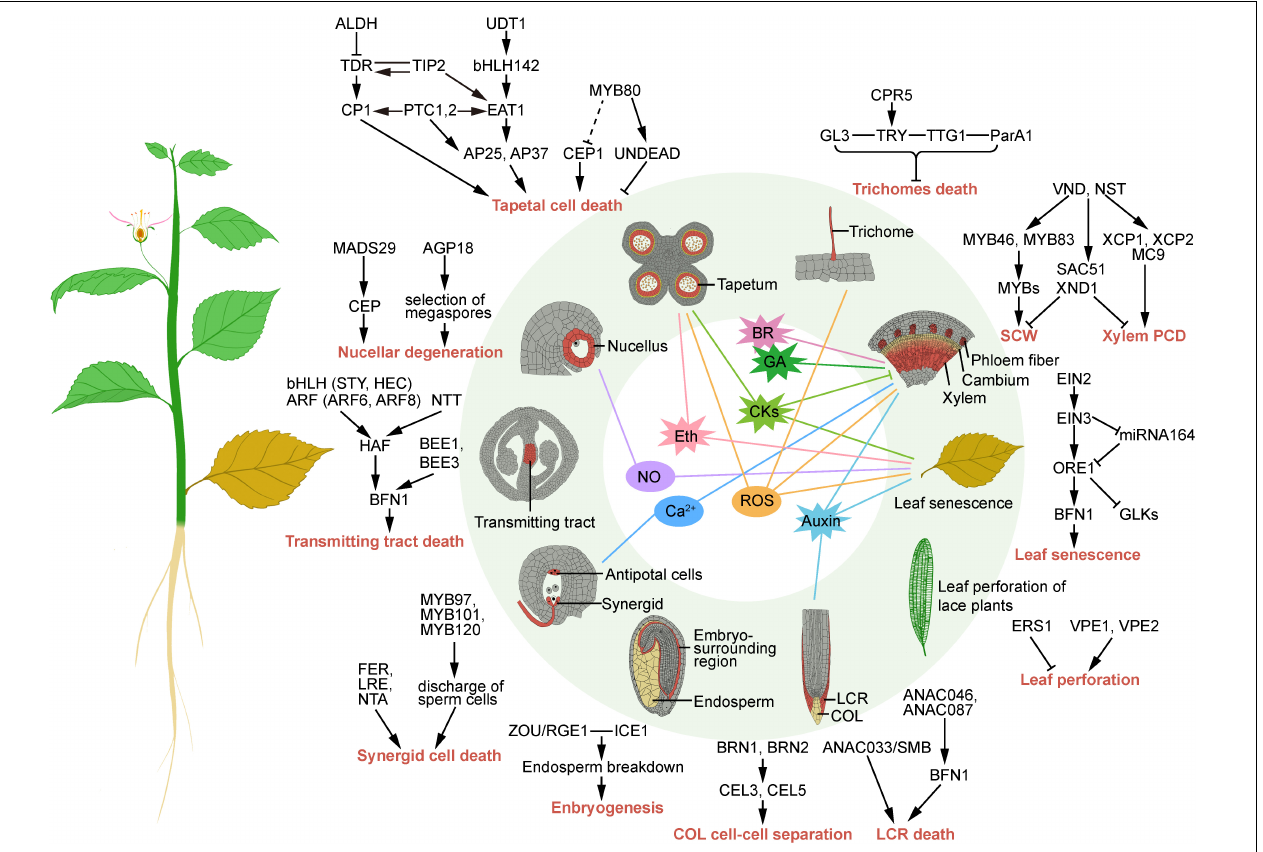
FIGURE 1 | Schematic representation of the transcriptional regulation and signaling of developmental programmed cell death in plants. Arrows and a “T” at the ends of lines represent transcriptional activation and repression, respectively. Lines without arrows or a “T” represent protein-protein interactions; dotted line represents unclear